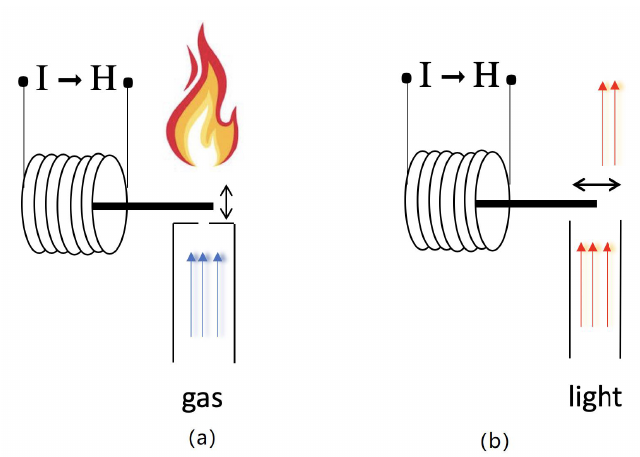
Figure 1. A schematic proposal for: ( a ) a simple open / close gas valve, or ( b ) light flux shutter